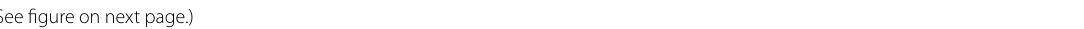
Fig. 1 Six types of nutlet morphology in the studied species. a – h Type I; (a-d) Heterocaryum rigidum ; a , b: An overview photograph of nutlet = with stereomicroscope and SEM. c , d: The close-up views of the nutlet disk with “papilla verrucose with verrucae minutely muricate”. (e–h) Pseudolappula siniaca ; e , f: An overview photograph of nutlet with stereomicroscope and SEM. g , h: The close-up views of the nutlet disk with “papilla with aggregate verrucose in the center”. i-o Type II . ( i , j) Lappula. barbata ; (k , l) Lappula. Microcarpa ; (The more detail of these two species were described between different specimens in Fig. 3). Lappula semiglabra m , n: An overview photograph of nutlet with stereomicroscope and SEM. o: The close-up views of the nutlet disk.